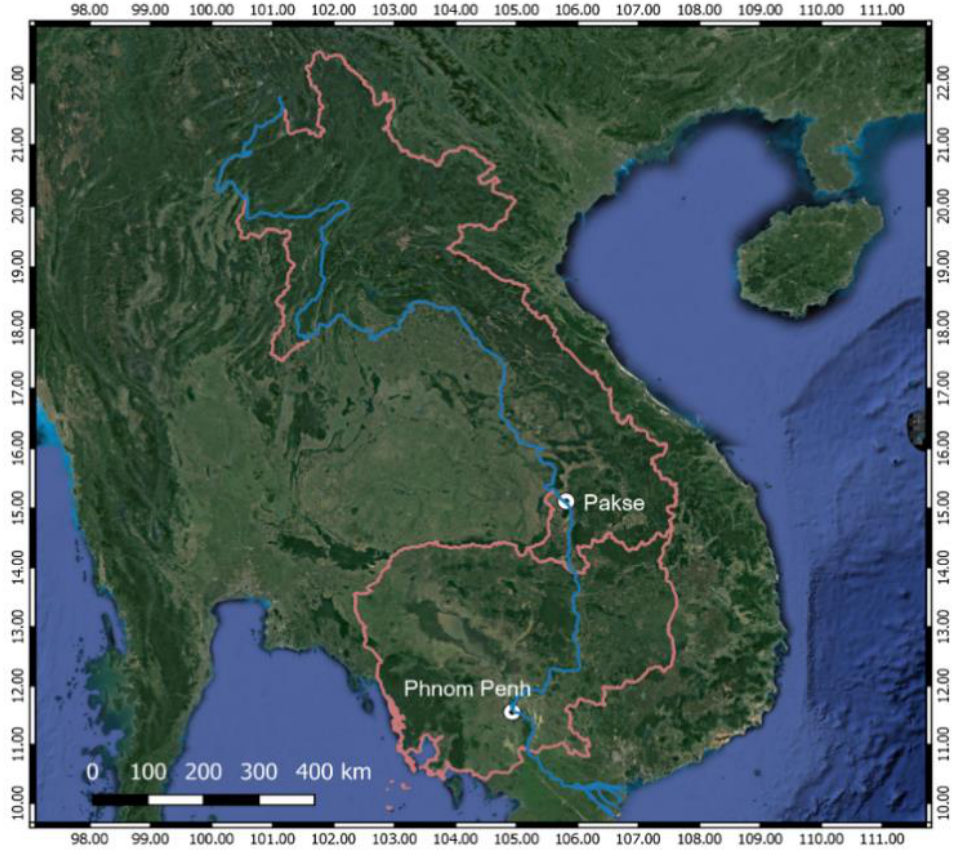
Figure 1. Location details of the countries of Pakse (Laos) and Phnom Penh (Cambodia), where the experiments were conducted, and the course of the Mekong River (blue line).